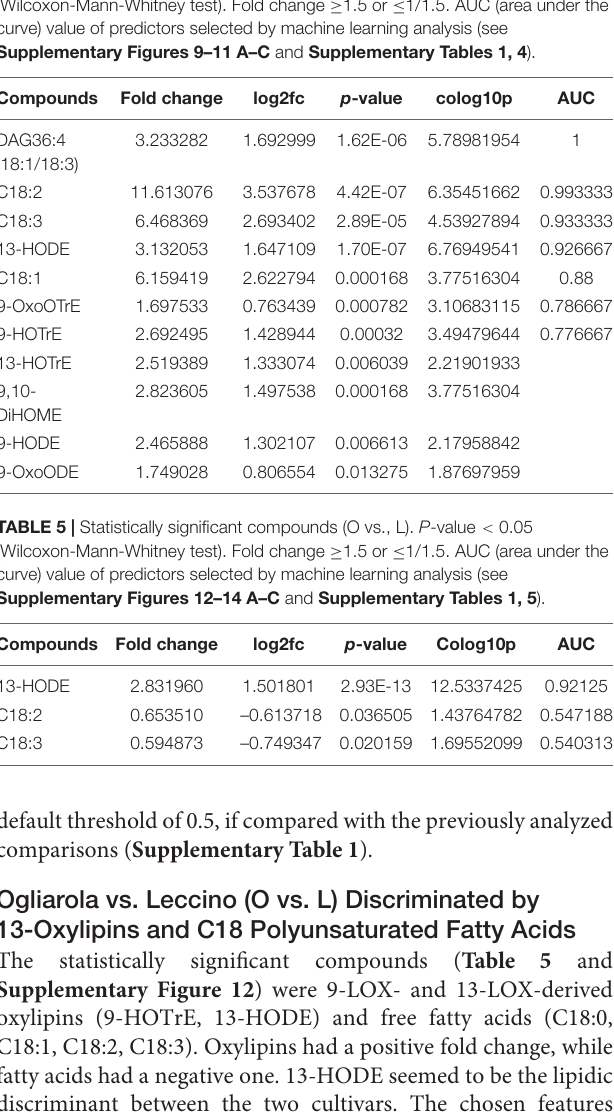
Supplementary Figure 12 ) were 9-LOX- and 13-LOX-derived